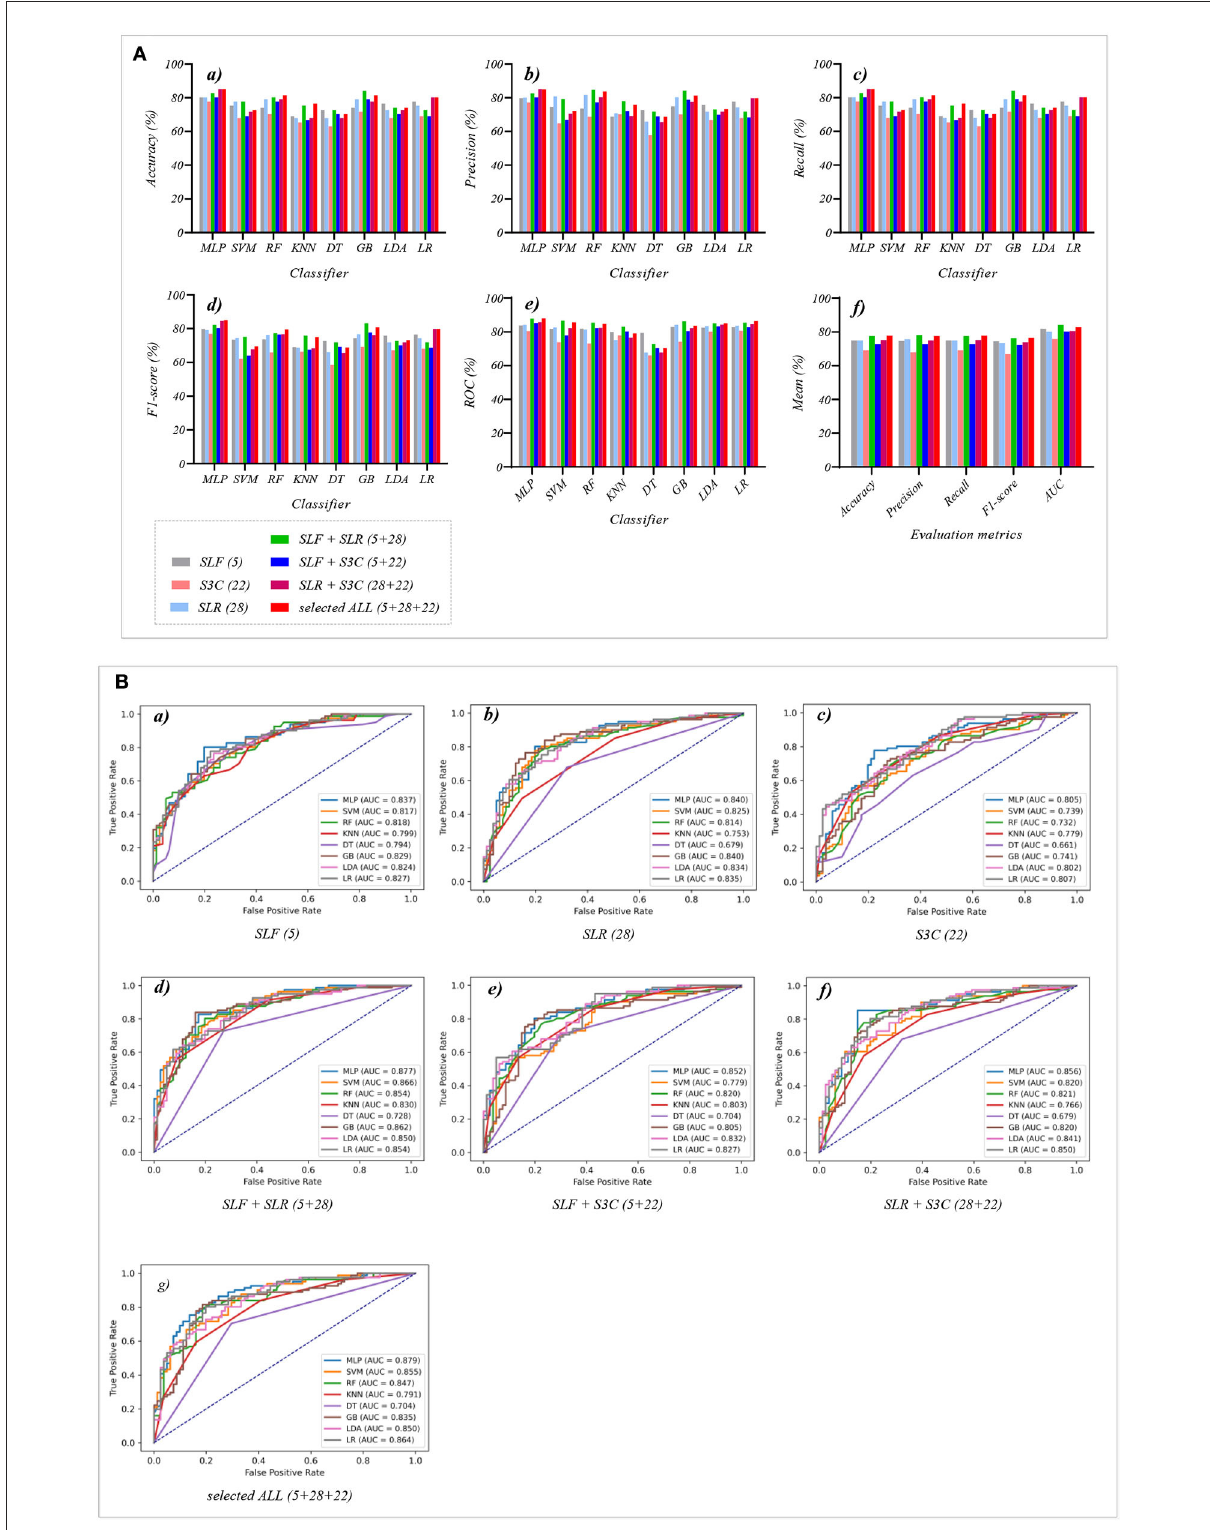
FIGURE5 The evaluation metrics pictures and ROCs of eight classifiers with seven selected features (three selected features and four selected combination features in Experiment 2). (A) The evaluation metrics pictures include (a) Accuracy, (b) Precision, (c) Recall, (d) F1-score, (e) AUC, and (f) Mean. (B) ROCs of the ML classifiers include (a) SLF (5), (b) SLR (28), (c) S3C (22), (d) SLF 22), and (g) SLF +